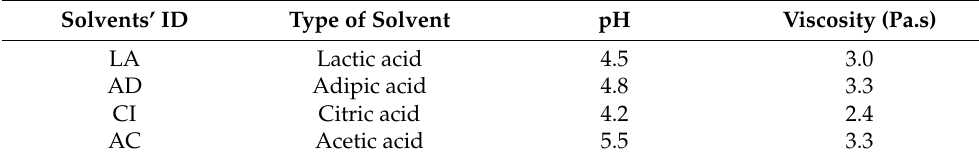
Table 1. pH and viscosity of different chitosan